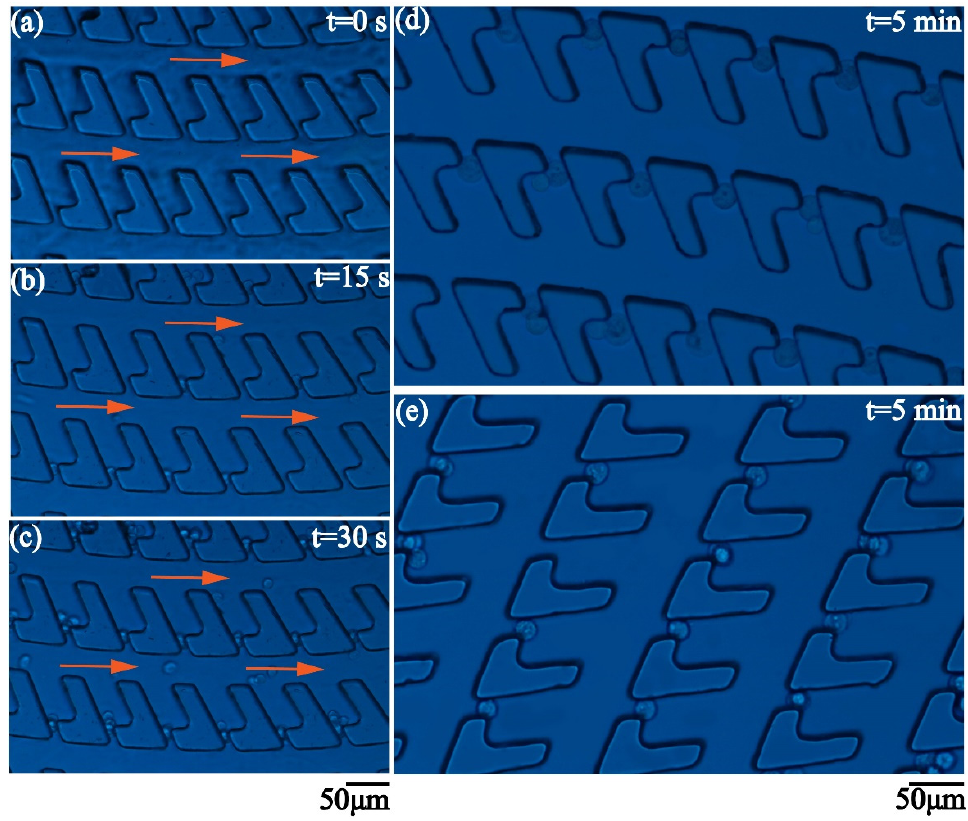
Figure 7. ( a – c ) Time-lapse montage of the procedure of cell trapping. ( d , e ) Microscopic images demonstrating that the traps in the different parts of the dentate spiral channel capture the 4T1 cells after 5 min.